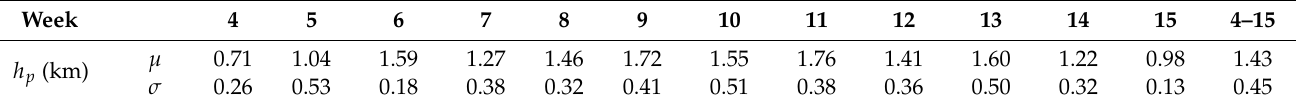
Table 1. Weekly means ( µ ) and standard deviations ( σ ) of h P